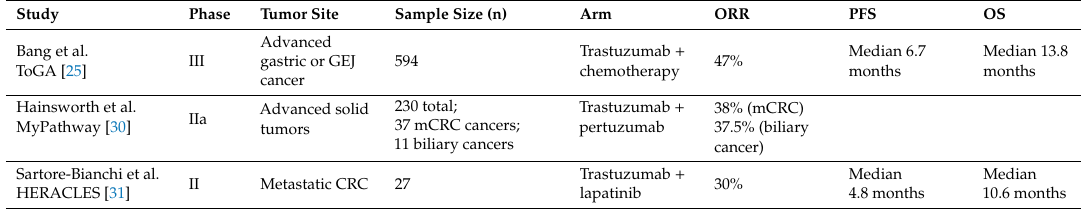
Table 3. HER2 status and therapeutic targets (selected studies).